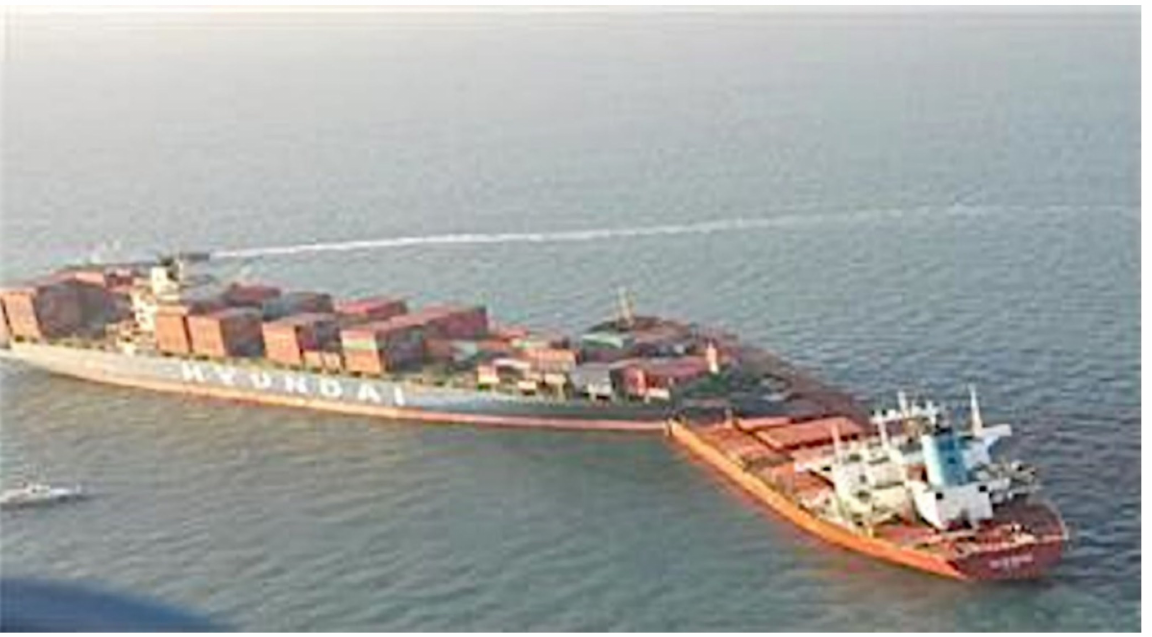
Figure 14. Collision accident between HYUNDAI CONFIDENCE and PACIFIC